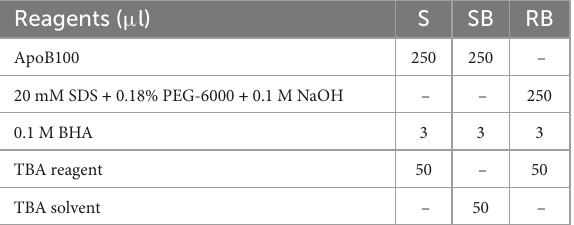
TABLE 5 Assay set up for apoB100-MDA